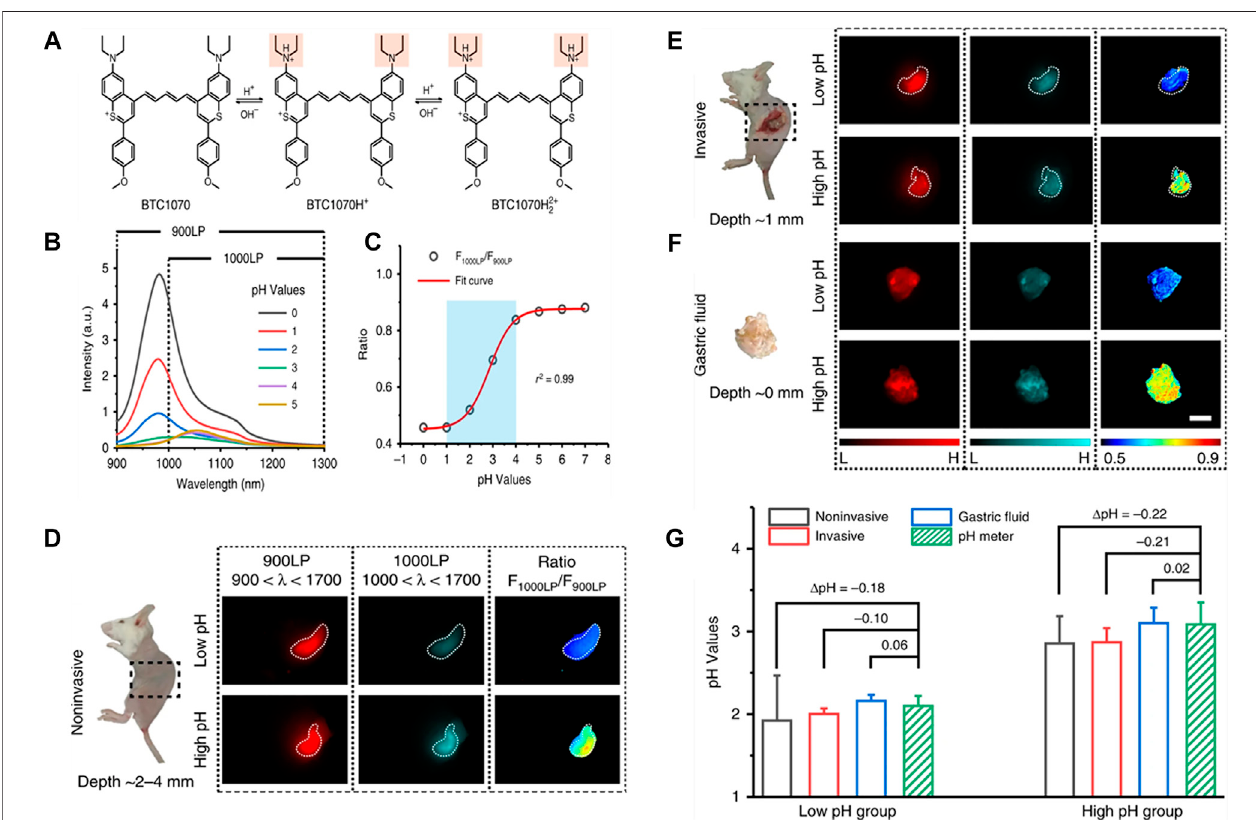
FIGURE 7 | Protonation of BTC1070 and the corresponding spectra changes. (A) Protonation mechanism of NIR-II fl uorophore BTC1070 showing stepwise protonation onnitrogen atoms. (B) Thecorresponding fl uorescence spectraexcitedat808 nmat various pHvalues. (C) Plot of fl uorescence ratiochangesasafunction ofpHvalues.Ratio (cid:1) F 1000LP /F 900LP ,F 1000LP andF 900LP denotetheintegratedintensityatwavelengthof1,000 – 1,300 nmand900 – 1,300 nm,respectively. (D – G) Invivo ratiometric fl uorescence imaging of gastric pH. (D,F) Left: digital photographs of mice and dissected stomach denote three imaging modes. (D) noninvasive imagingat ∼ 2 – 4 mm tissue depth; (E) invasive imagingofgastric fl uidcovered by ∼ 1 mm thickness ofgastric wall; (F) imagingofexposedgastric fl uid. (G) Comparison ofpHvaluesinmicestomachmeasuredbyratiometric fl uorescenceimagingandstandardpHmeter.Datapointwithitserrorbarstandsformean ± s .d.derivedfromn